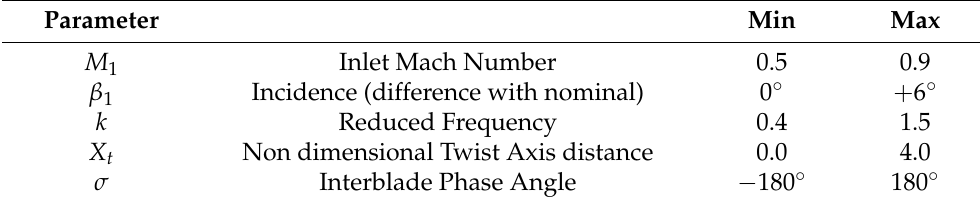
Table 1. Intervals of design